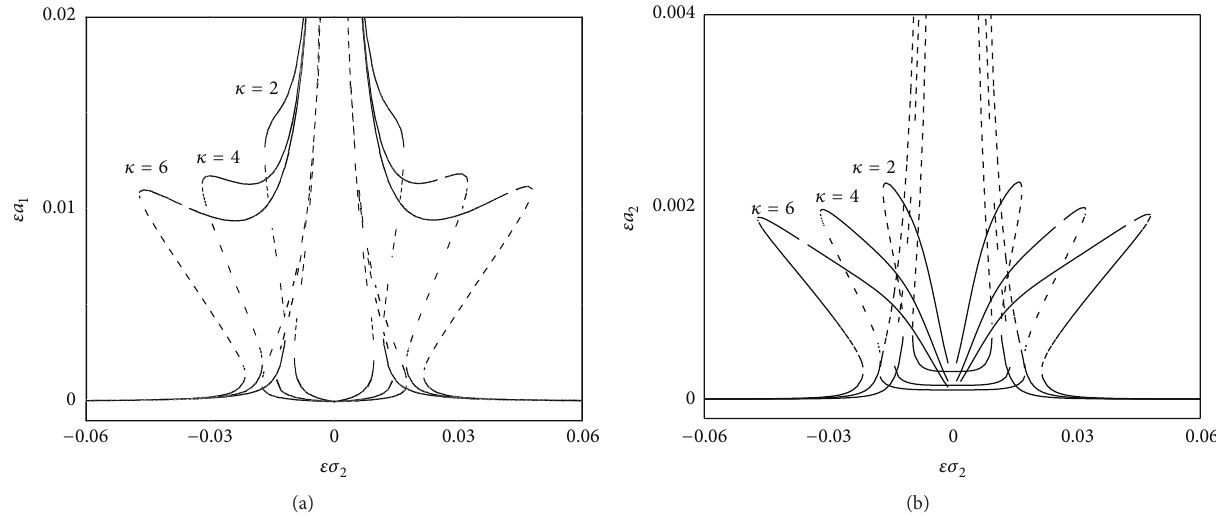
Figure 16: Amplitude-frequency curves of the summation resonance for different nonlinearity: (a) the first-mode and (b) the second-mode coefficients.